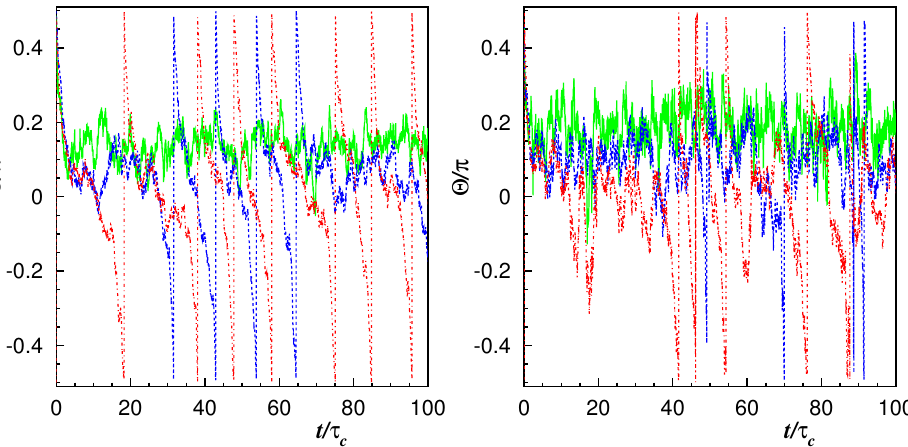
Figure 3. Time behavior of the inclination angle Θ at S ∗ = 0.80 ( left ) and S ∗ = 0.95 ( right ) for κ / ( k B TR 0 ) = 6.58 with λ = 1 (full green line), 7 (dashed blue line), 15 (dot-dashed red line). The time-averaged values (cid:104) Θ (cid:105) are depicted in Figure 4, together with the root-mean- (cid:112) (cid:104) ( ∆Θ ) 2 (cid:105) . The transition from the TT to the square (rms) fluctuation values σ Θ =